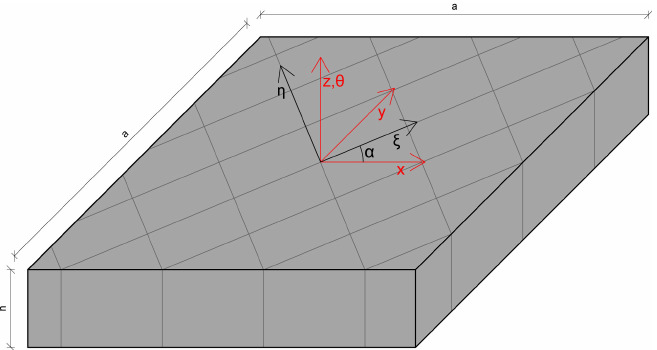
Figure 1. Relation between orthotropic and global coordinates in the plate with orthotropic